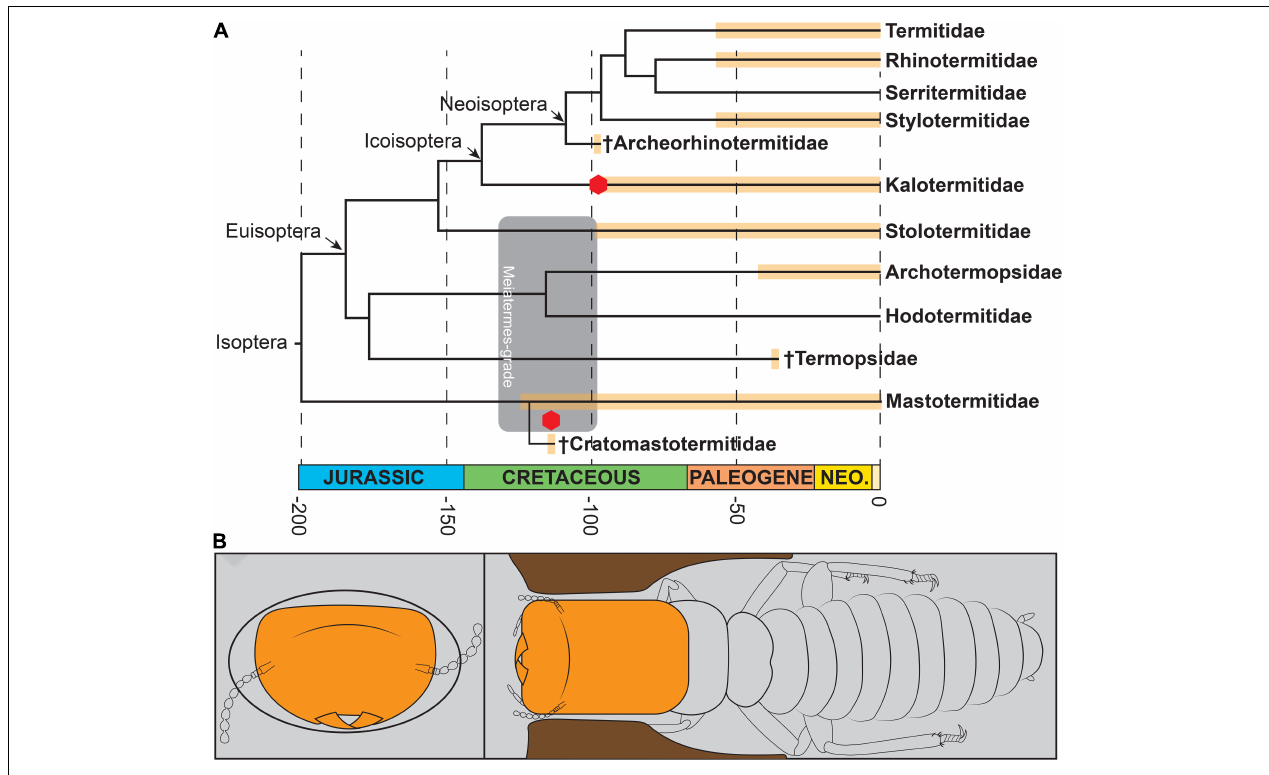
FIGURE 4 | Dated phylogeny of termites, and phragmotic behavior of a Valkyrie. (A) Dated phylogeny of living and fossil taxa of Isoptera with occurrences of Valkyries indicated by red hexagon (datings from Jouault et al., 2021). (B) Schematic reconstruction of phragmotic behavior of a